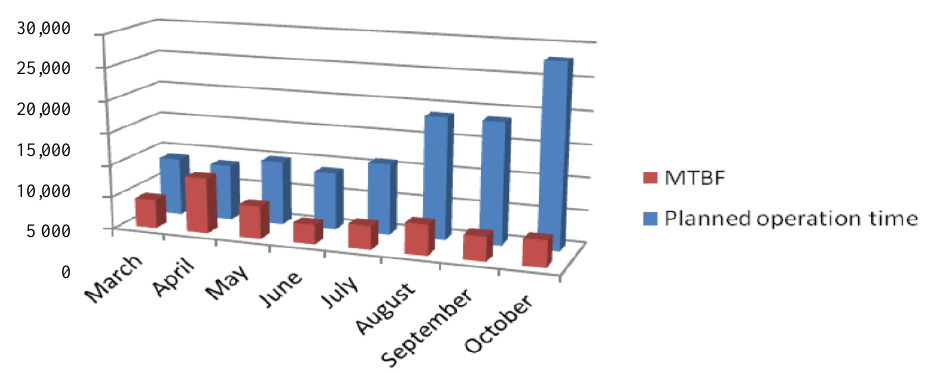
Figure 6. Impact of planned operation time of the station of final functionality.